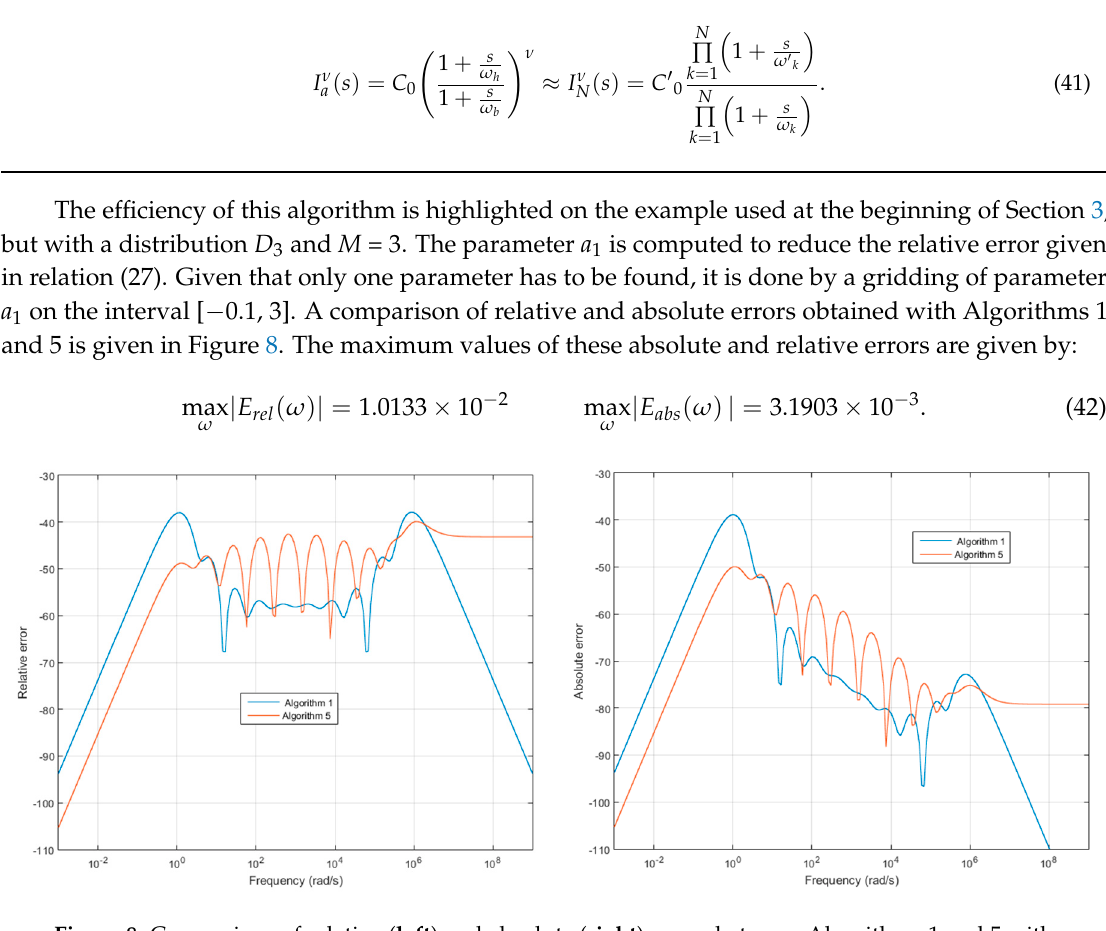
Figure 8. Comparison of relative ( left ) and absolute ( right ) errors between Algorithms 1 and 5 with distribution D 3 .